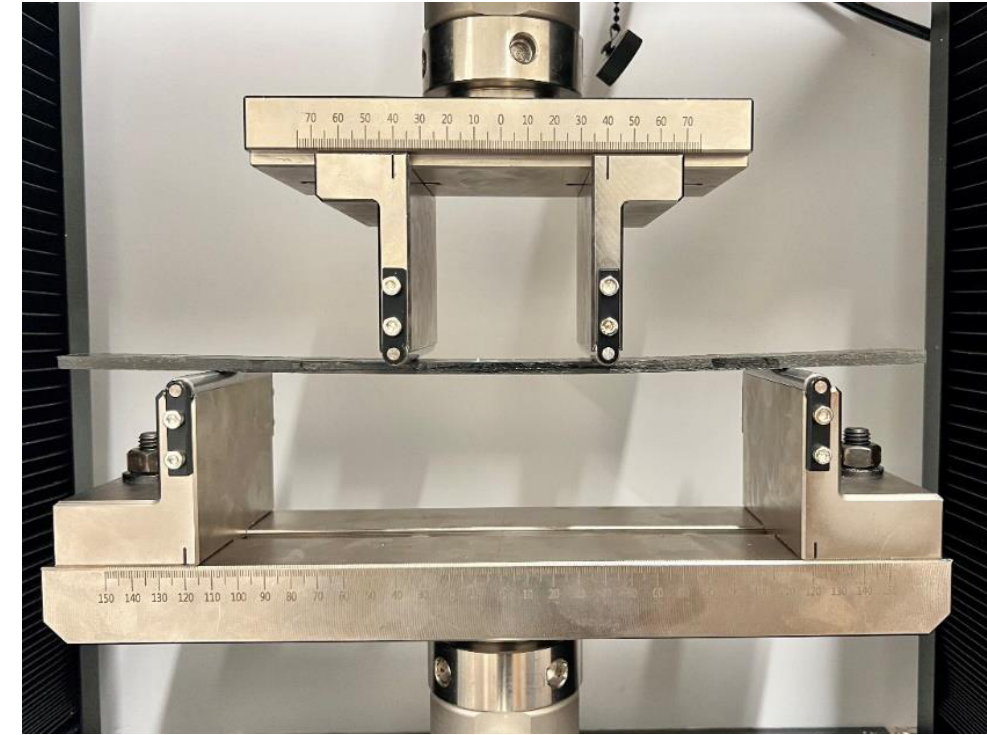
Figure 3. Repaired specimen under four-point bending test.